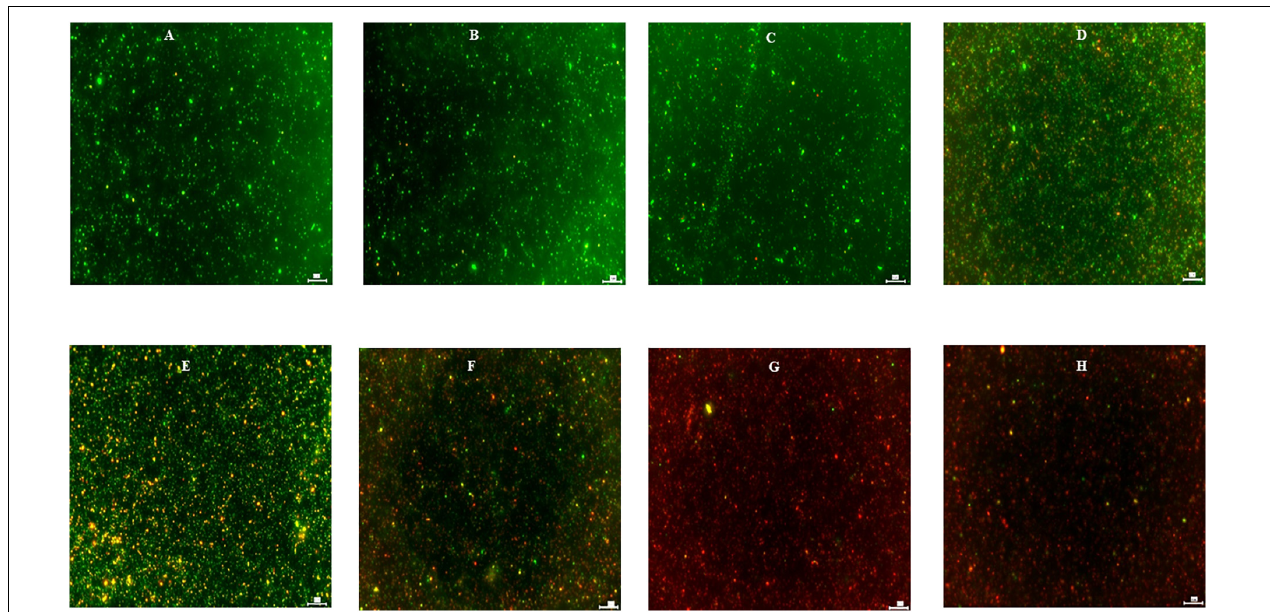
FIGURE 7 | Effect of DMSO (B) , ethanol (C) , turmeric (D) , curcumin (E) , allyl sulfide (F) , garlic oil (G) , and ginger oil (H) on viability of C. jejuni S-8 cells determined by Live/Dead BacLightTM bacterial viability stain under fluorescent microscope at × 20. Cells were exposed to 0.25% of phytochemicals or buffer [control; (A) ] for 5 min at room temperature before examination. Scale bar is 50 µ m.